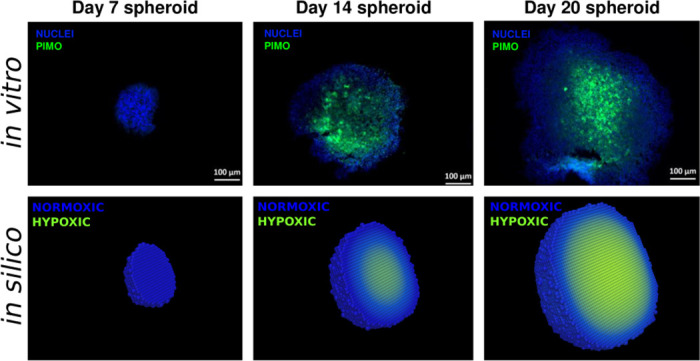
Hypoxic and normoxic cells.Top: Images from in vitro experiments performed by Voissiere et al. [35], in which hypoxic cells are stained green by pimonidazole and normoxic cells are stained blue. Bottom: Images from in silico experiments performed in this study, where hypoxic cells (pO2 ≤ 10 mmHg) are coloured green and normoxic cells (pO2> 10 mmHg) are coloured blue.